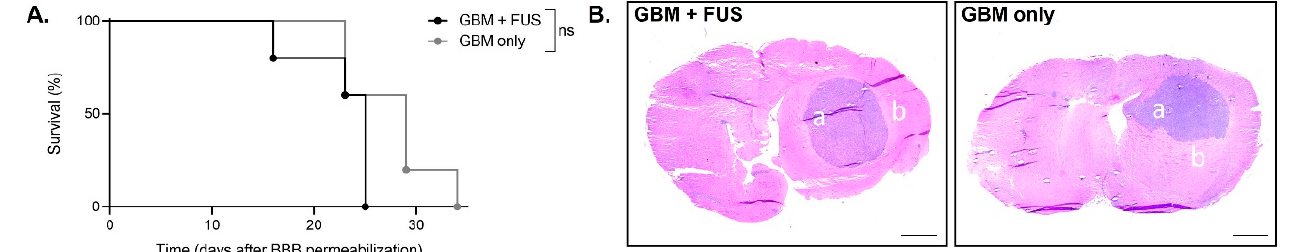
Figure 6. Survival and histological analyses following tumor grafting and BBB permeabilization by focused ultrasound. ( A ) Kaplan-Meier survival curves of the animals of group “GBM + FUS” (tumor-bearing animals undergoing BBB permeabilization) and group “GBM only” (tumor-bearing animals without FUS-mediated BBB permeabilization), n = 5 per group; ns: not significant; ( B ) Representative coronal section of Hematoxylin and Eosin staining of tumor-bearing animals that had been exposed or not to FUS-mediated BBB permeabilization (group “GBM + FUS” and “GBM only” respectively) at end point. The a represents relatively low-enhancing glioblastoma tumor cells forming a spheric tumor lesion and the b represents normal brain tissue surrounding the tumor (scale bar: 1 mm).